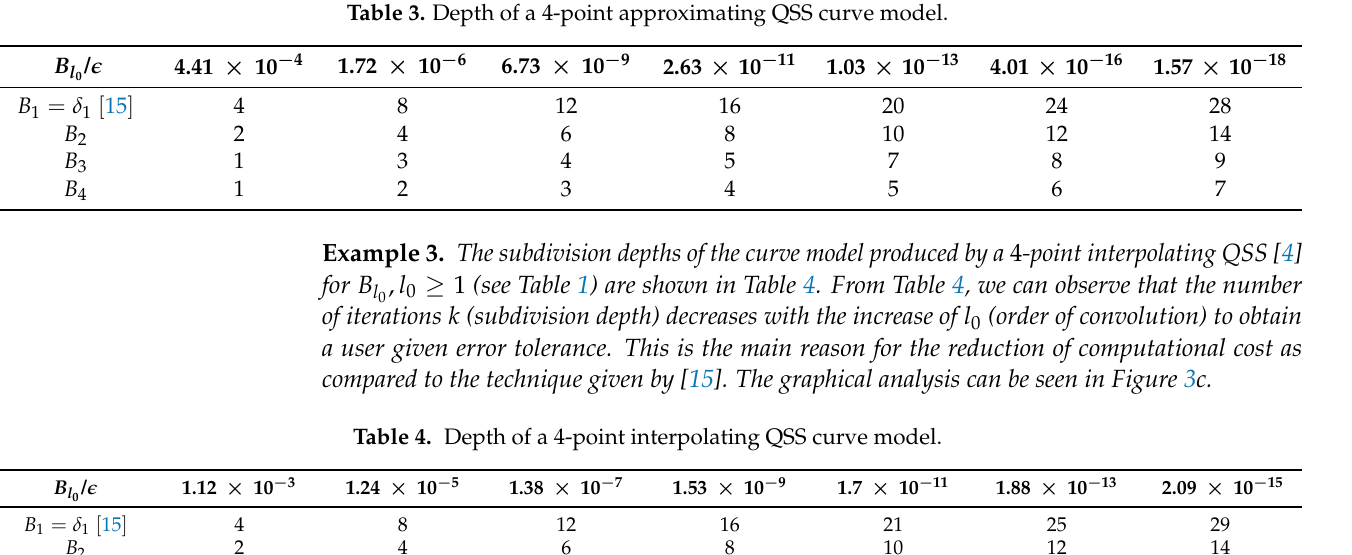
Table 1. Values of B l